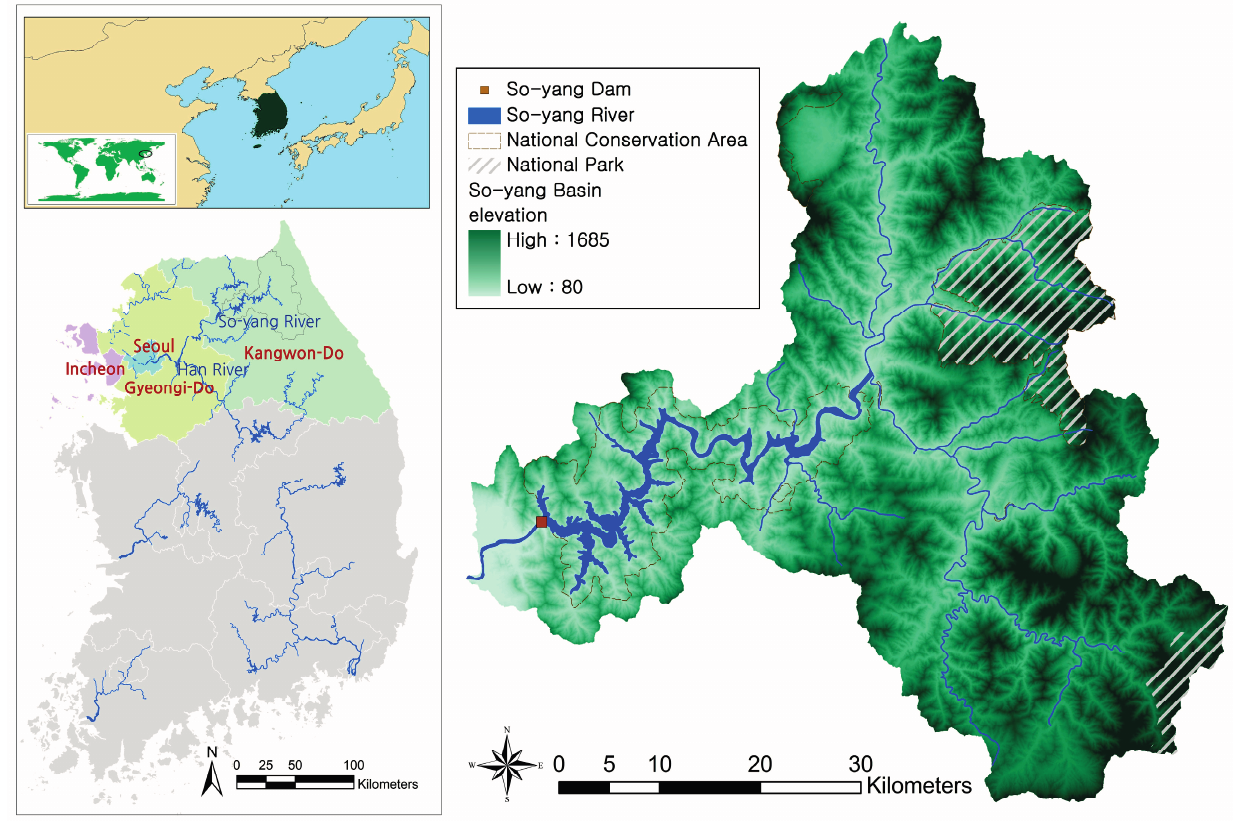
Figure 1. So-yang River Basin in South Korea, Study area (128°19 ′ 22 ″ ~128°12 ′ 11 ″ N, 37°53 ′ 53 ″ ~37°58 ′ 50 ″